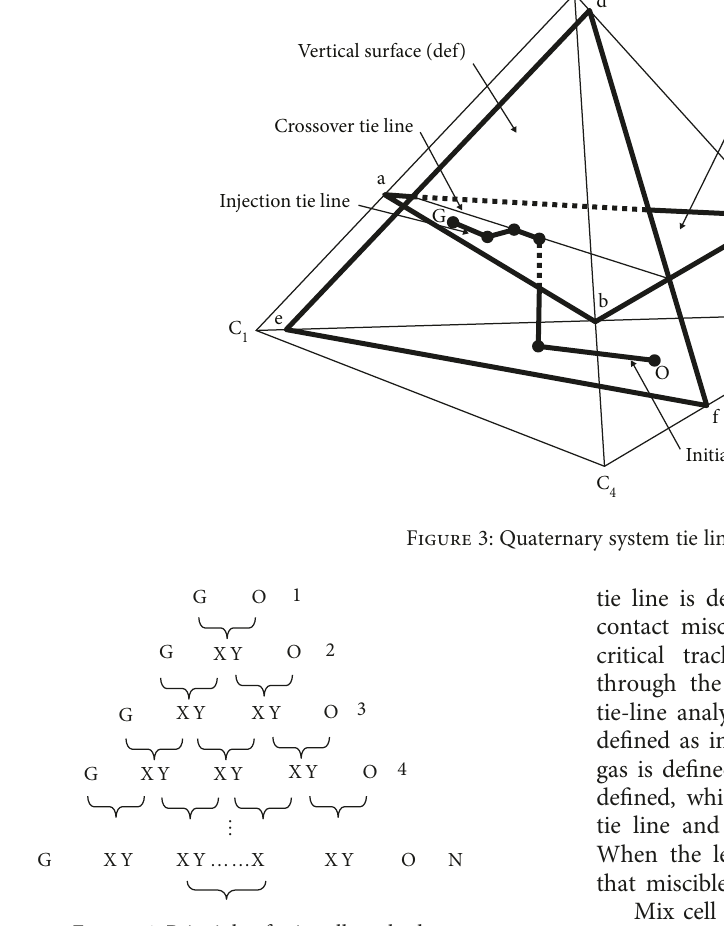
Figure 4: Principle of mix cell